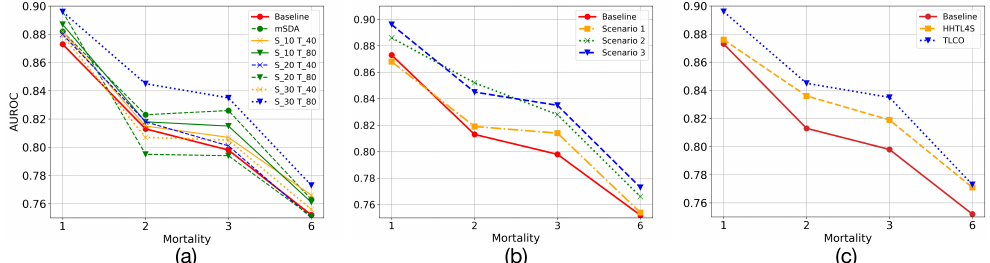
Figure 7. Comparison results transferring samples from AKI to ESRD using TLCO: ( a ) shows the performance of mSDA and TLCO modifying dimension of codes in source (S) and target (T) domains; ( b ) shows three possible scenarios to tackle data imbalance in ESRD; ( c ) compares proposed solution with HHTL. Table 2. Imbalance in ESRD generated by increasing training samples in ESRD from AKI. Scenarios 1, 2, and 3 refer to the transfer of samples from Classes 0, 1, and combining both classes, respectively. Generated Data Imbalance Mortality